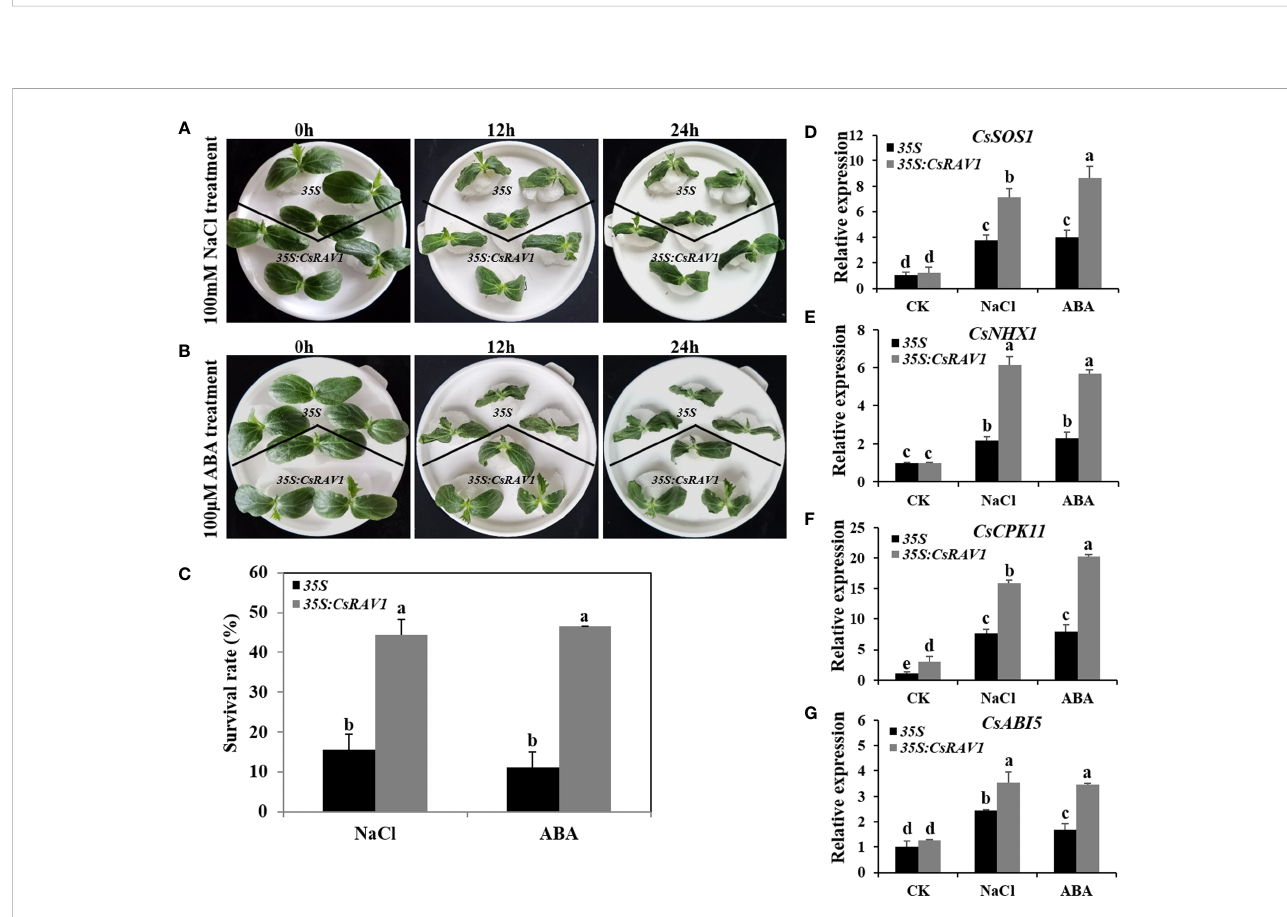
FIGURE 7 Overexpression of CsRAV1 improved NaCl and ABA tolerance in cucumber seedlings. (A, B) Phenotypes of 35S and 35S : CsRAV1 cucumber seedlings treated with NaCl and ABA under hydroponics. (C) Survival rate of 35S and 35S : CsRAV1 plants after 24 h NaCl and ABA treatments. The transcript levels of CsSOS1 (D) , CsNHX1 (E) , CsCPK11 (F) , and CsABI5 (G) genes in 35S and 35S : CsRAV1 cucumber seedlings were analyzed with qRT-PCR under NaCl and ABA treatment for 6 h. The cucumber b -actin gene was used as internal control. Error bars were the standard errors (SE). Different letters indicated signi fi cant differences (P <